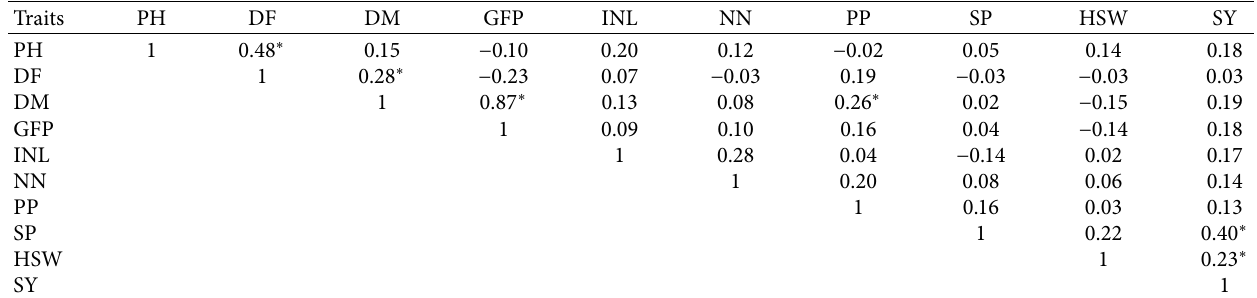
Table 7: Phenotypic correlation coefcient between diferent yields-related traits at Miesso during 2018 cropping season.